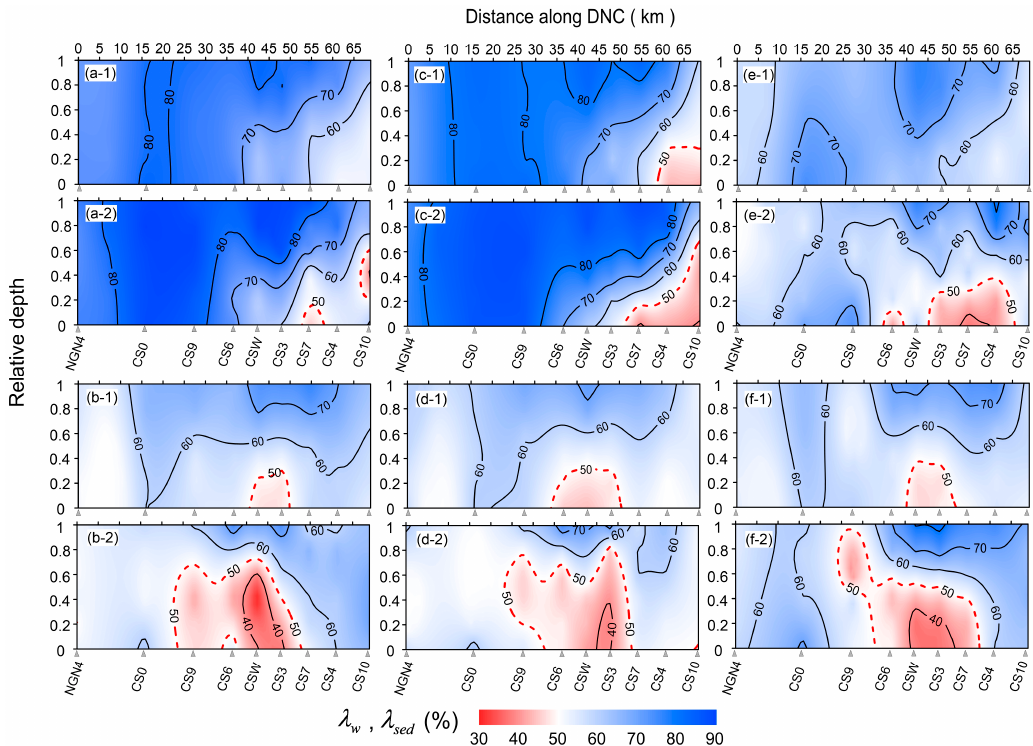
Figure 6. Percentages that ebb water / sediment transport account for the total water / sediment transport along the DNC: ( a – f ) represent six observations, respectively (according to Figure 2). ( 1 )—and ( 2 )—represent water transport λ w and sediment transport λ sed , respectively. The red dashed lines represent the value 50%. Values > 50% denotes ebb-dominated and seaward residual transport, while values < 50% denote flood-dominated and landward residual transport.